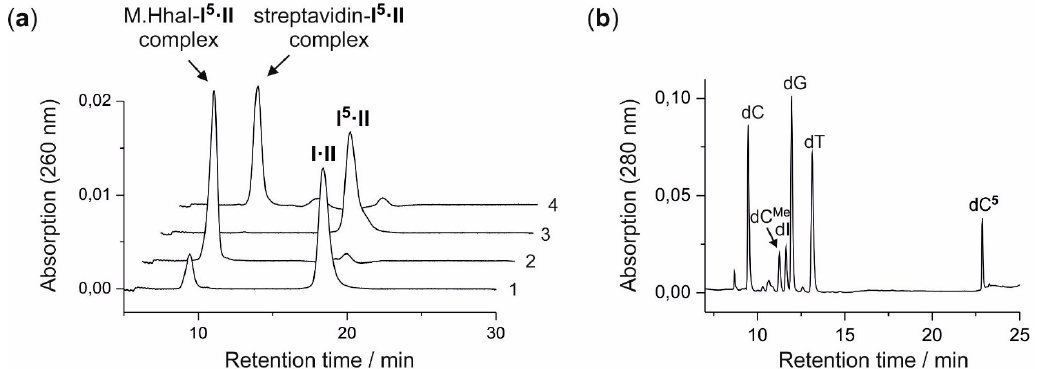
Figure 2. Biotin labeling of duplex ODN I·II with aziridine cofactor 5 and M.HhaI. ( a ) Anion-exchange HPLC analysis of the coupling reaction between the aziridine cofactor 5 and the duplex I·II by M.HhaI. (Trace 1) Analysis directly after mixing the components; (Trace 2) analysis after 3 h of incubation at 37 °C; (Trace 3) analysis after 3 h of incubation at 37 °C followed by the release of the modified duplex I 5 ·II from the protein-DNA complex by heat denaturation; (Trace 4) analysis of streptavidin binding to I 5 ·II ; ( b ) Enzymatic fragmentation of the product duplex I 5 ·II with DNase I, phosphodiesterase from Crotalus adamanteus , phosphodiesterase from calf spleen and alkaline phosphatase analyzed by reverse-phase HPLC. The modified nucleoside (dC 5 ) elutes after 2’-deoxycytidine (dC), C 5-methyl-2’-deoxycytidine (dC Me ), 2’-deoxyinosine (dI), 2’-deoxyguanosine (dG) and 2’-deoxythymidine (dT) (2’-deoxyadenosinewas converted to dI by contaminating adenosine deaminase activity during the fragmentation reaction).